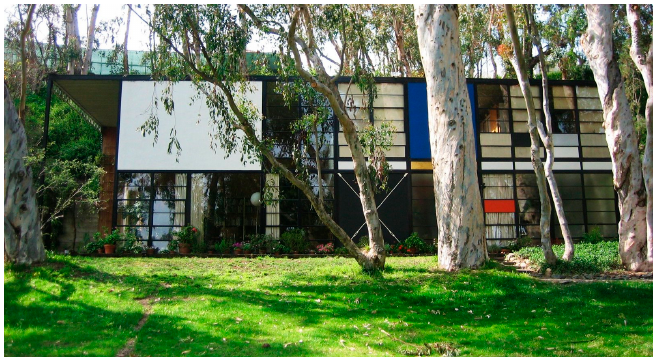
Figure 9. Case Study House #8 by Charles and Ray Eames, Eames House, Santa Mónica, Califórnia, 1945–1949 [17].